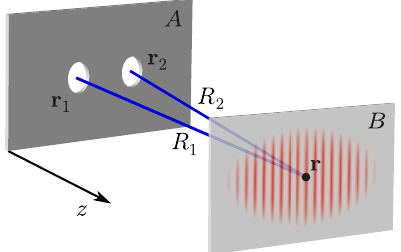
Figure 1. Illustration of Young’s two-pinhole